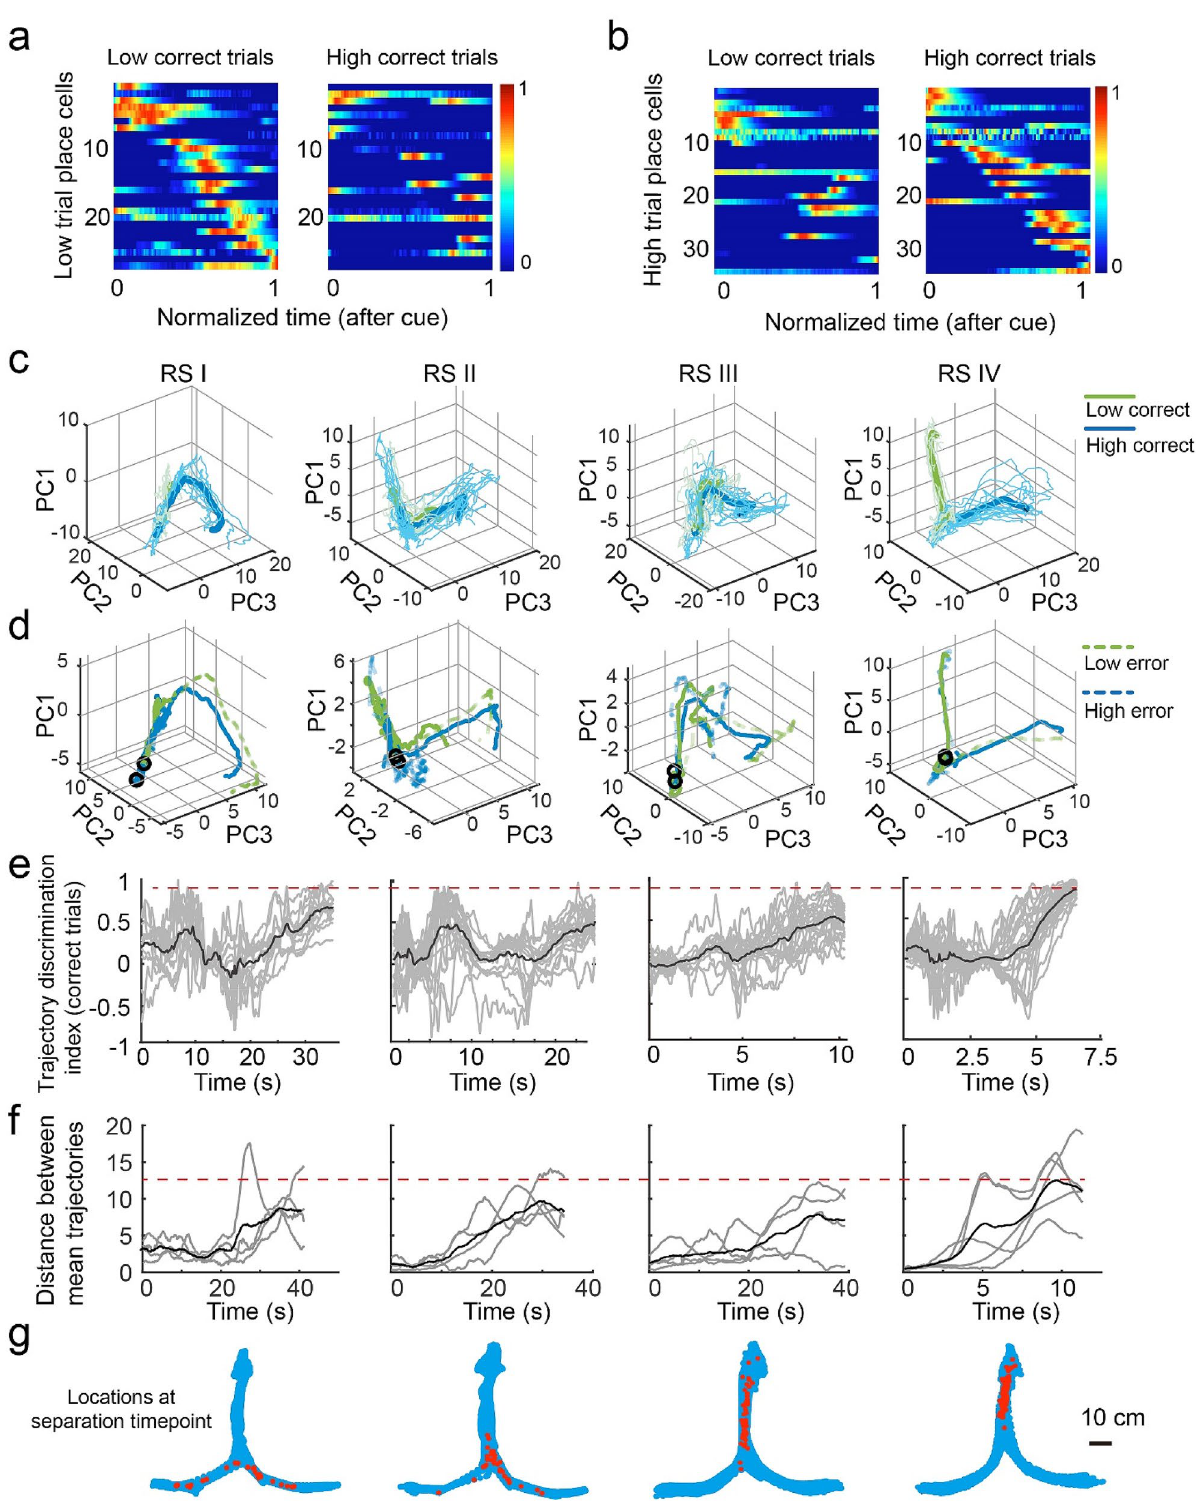
Figure 4. DGC ensembles convey information related to auditory decisions. ( a , b ) Sequential activity of place- coding cells in low and high trials and distinct sequences of place-coding DGCs in different trial types. ( c ) Example neural trajectories in low (green) and high (blue) correct trials in a 3-D space. Thin lines indicate individual trials, and thick lines indicate the mean trajectory. ( d ) Solid lines indicate the mean trajectory in correct trials, and dashed lines indicate the mean trajectory in error trials (e.g., the green dashed line corresponds to low trials in which the rat made an error). ( e ) Neural trajectory discrimination index in correct trials (gray, single trial index; black, averaged index), which indicates the similarity of a single trial trajectory to its own (index = 1) or opposite (index = − 1) trial type averaged value. ( f ) Distance between trajectories of two trial types (gray, single rat distance; black, averaged rat distance). ( g ) Locations of rats when the neural trajectories in two trial types